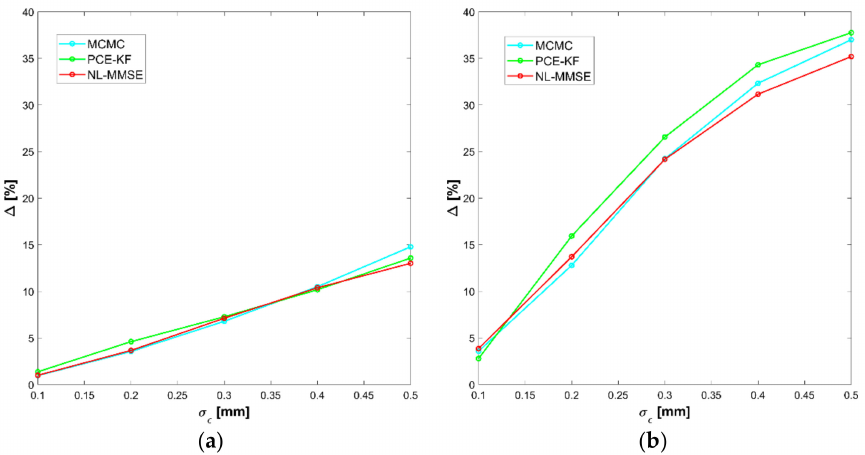
Figure 16. Percentage deviation in the updating according to different methods, variation with measurement error: ( a ) E true = E + s E and ( b ) E true = E + 3 s E . Results are compared for the MCMC method (in cyan), the PCE-KF method (in green) and the NL-MMSE method (in